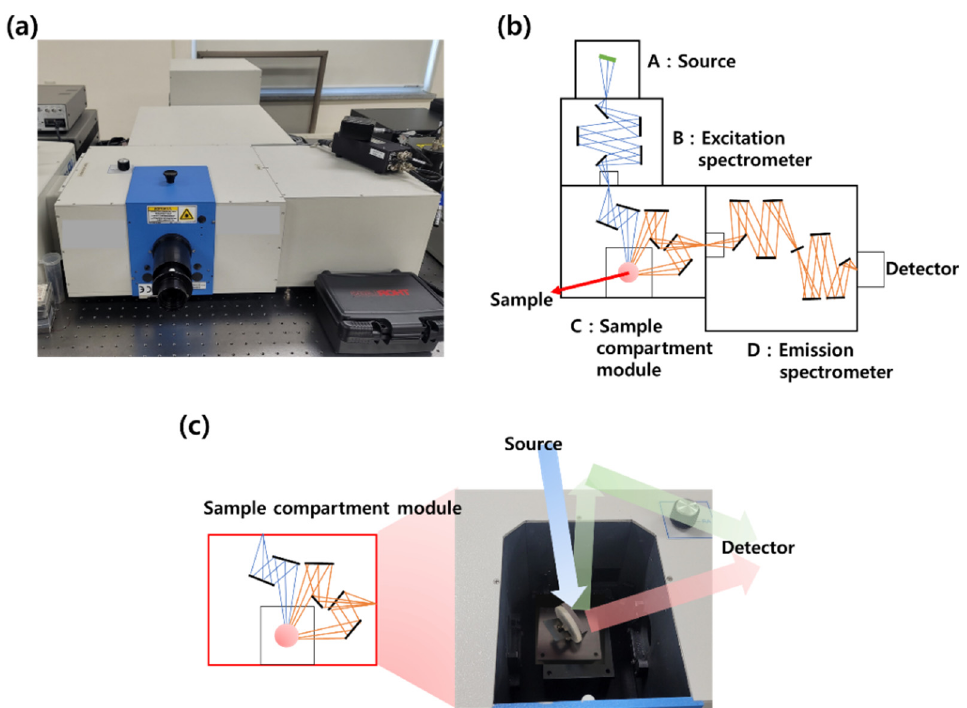
Figure 4. Schematic representation of the photoluminescence analysis: ( a ) real picture of apparatus setup; ( b ) path of the laser beam for analysis of plastic scintillator; ( c ) sample compartment module of plastic scintillator.